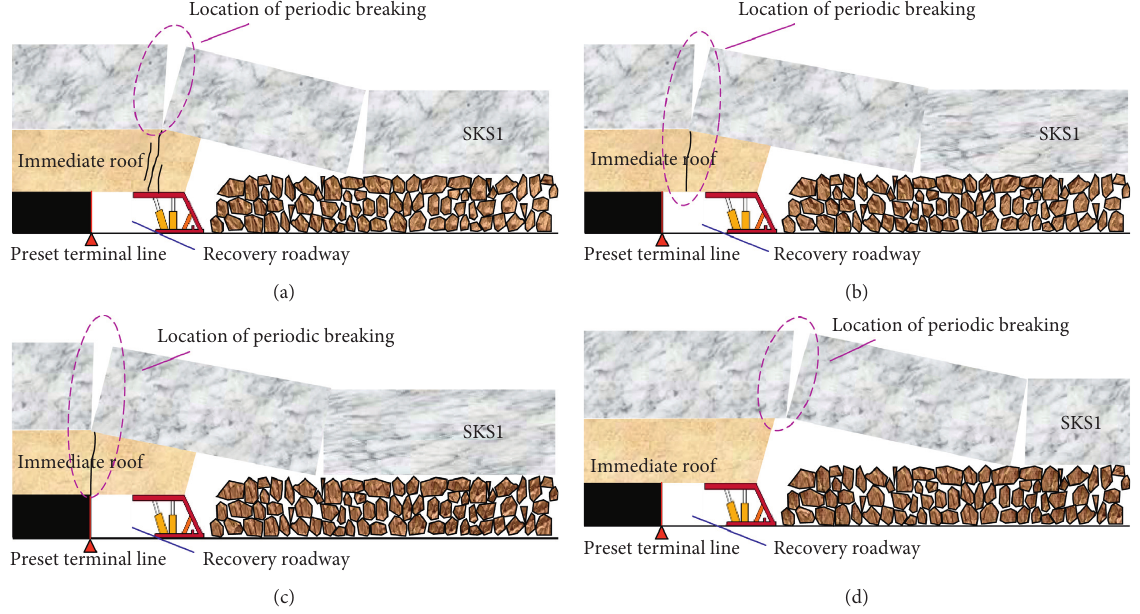
Figure 3: The position of periodic weighting during the extraction of equipment: (a) above the support; (b) above the recovery roadway; (c) along the coal wall; (d) above the gob.